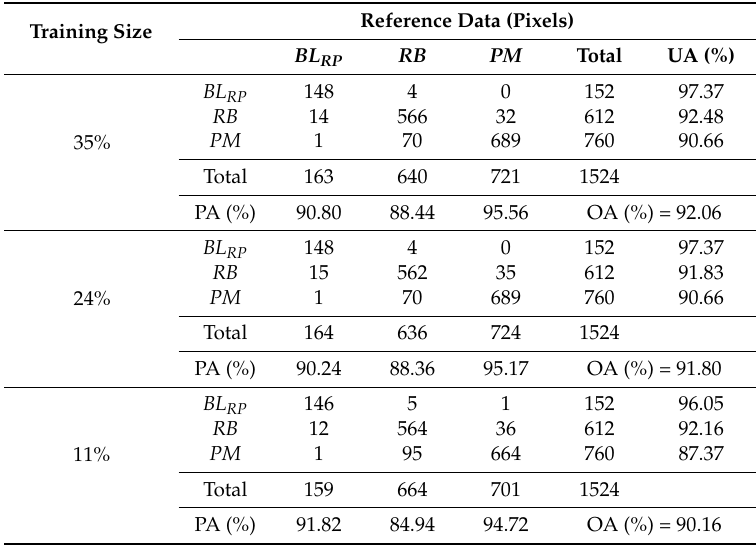
Table 4. Error matrix table of RP data.